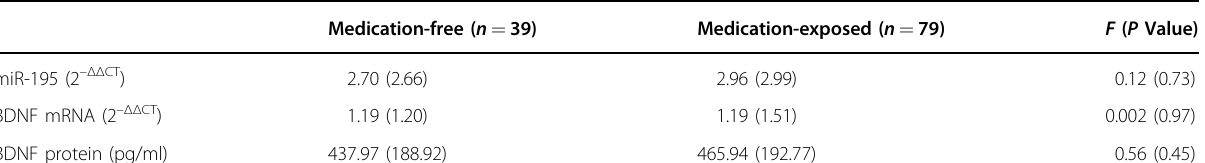
Table 4 Comparison of miR-195 expression blood BDNF mRNA levels plasma BDNF protein concentrations between medication-free patients and patients exposed in any antipsychotic